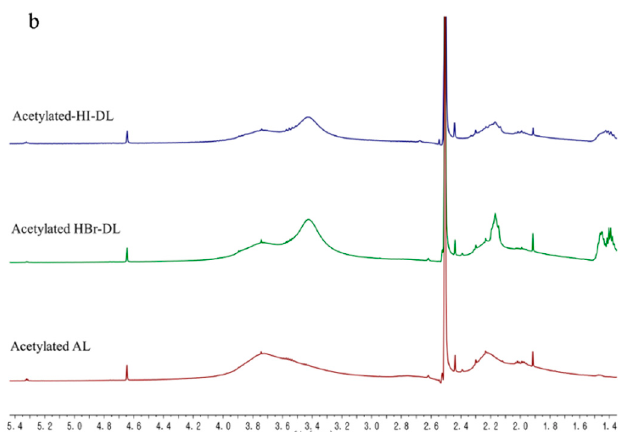
Figure 3. 1 H NMR spectra of ( a ) acetylated AL and demethylated lignins (DL); and ( b ) enlarged area of the methoxy and acetoxy group.